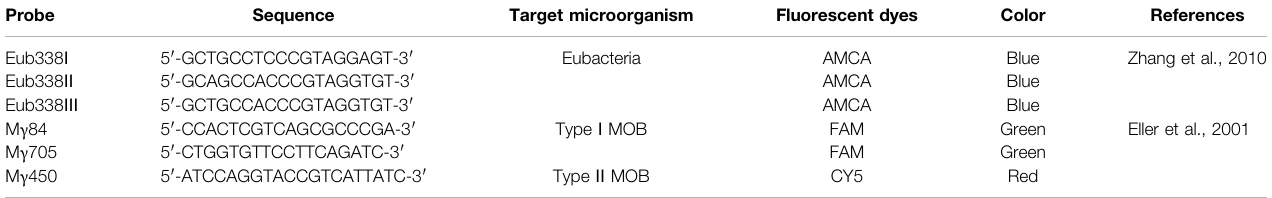
TABLE 2 | 16S r RNA-targeted oligonucleotide probes used in fl uorescence in situ hybridization. Probe